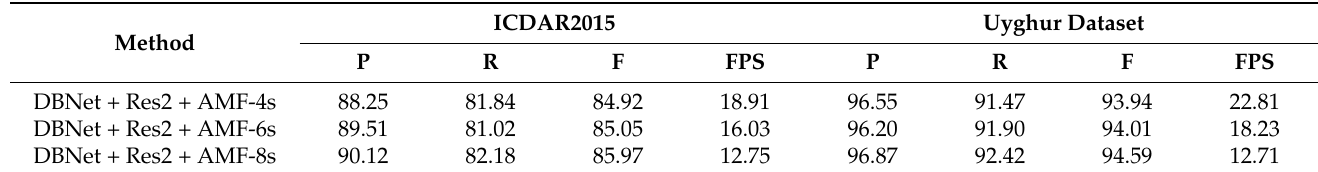
Table 1. The influence of residual block stratification scale.